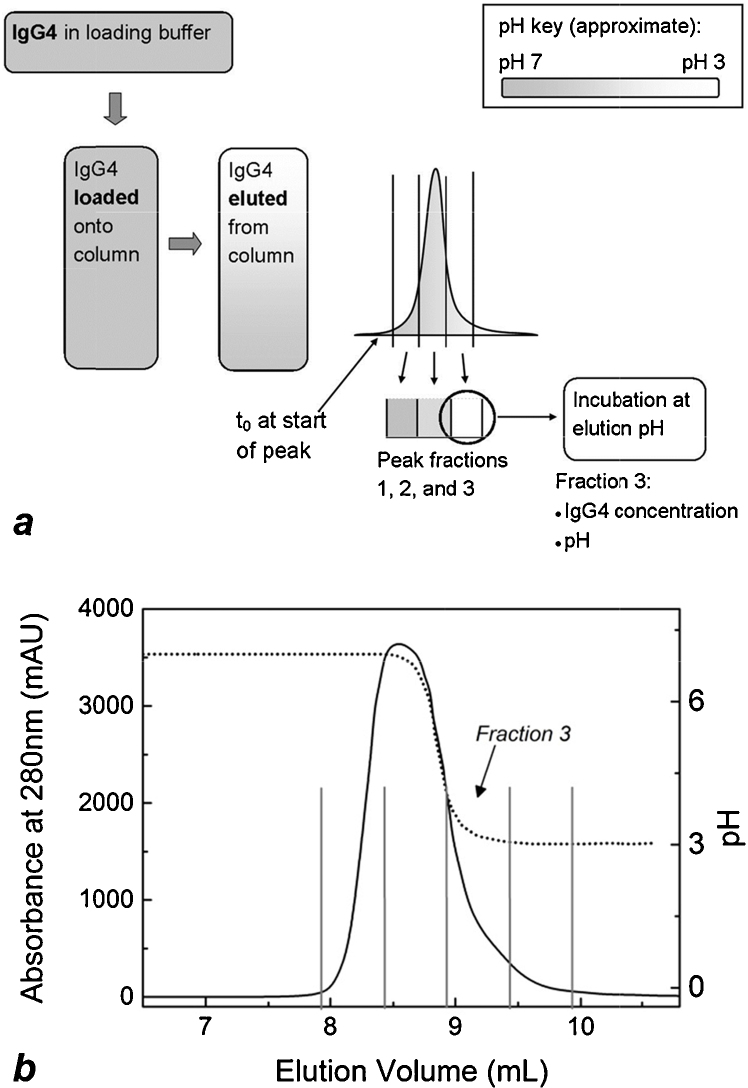
Schematic of experimental design where incubation at low pH follows protein A chromatography (a). Incubation is assumed to begin when the elution peak begins, denoted t0. Fractions containing approximately the first two thirds of the elution peak were at pH conditions considerably higher than the elution buffer pH. IgG concentration and pH in fraction 3 were the conditions reproduced in solution experiments for comparability with column experiments. A precise representation of the experimental outcome can be seen in (b), a chromatogram from a protein A chromatography run. The solid line (left y-axis) represents the IgG elution peak and the dotted line (right y-axis) indicates the pH of column effluent, as measured by the in-line pH probe. Here, flow of elution buffer begins at 7 mL elution volume. The last two fractions of the elution peak, indicated within vertical lines in (b), were at pH conditions low enough to induce aggregation.